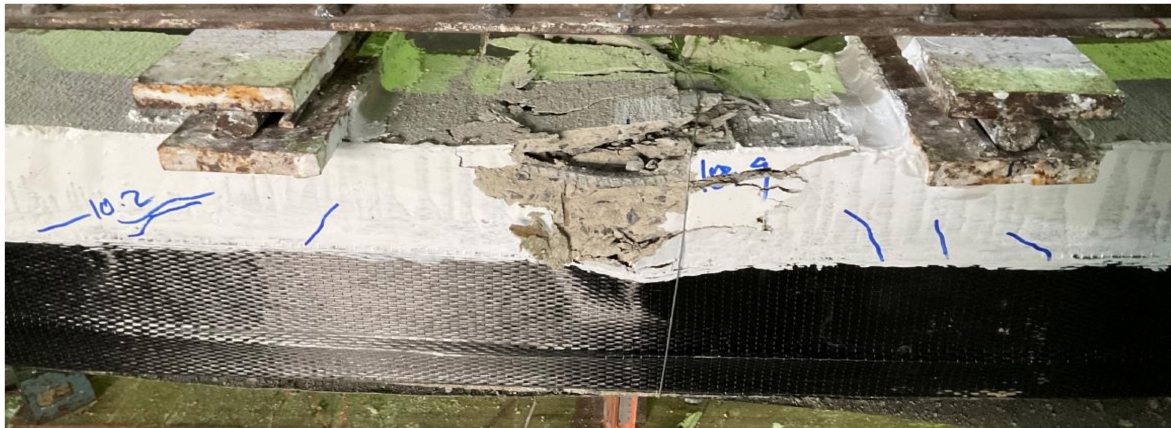
Figure 19. Comparison of load-deflection curves of beams with 100 mm square opening.